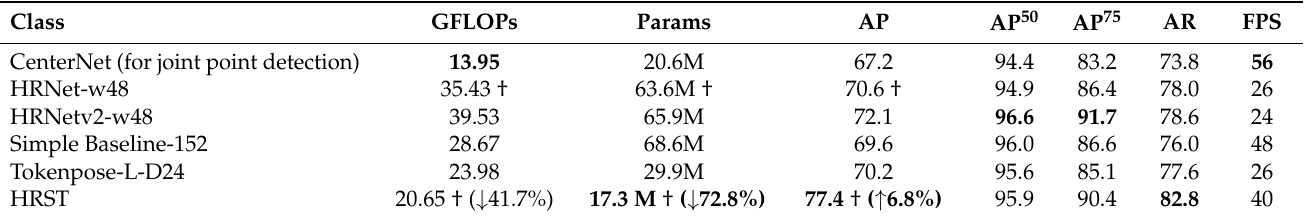
Table 4. Results of different joint point detection models on the joint point test set of pigs. AP 50 and AP 75 are the average precision when Object Keypoint Similarity (OKS) threshold is set to 0.5 and 0.75. AP and AR are average precision and average recall averaged over 10 OKS threshold (0.50:0.05:0.95). We calculated the percent difference in params, GFLOPs, and AP between models marked with the same symbol. ”†” marks the models we compared, and ” ↓ ” and ” ↑ ” indicate the decline and increase of the comparison results, respectively.